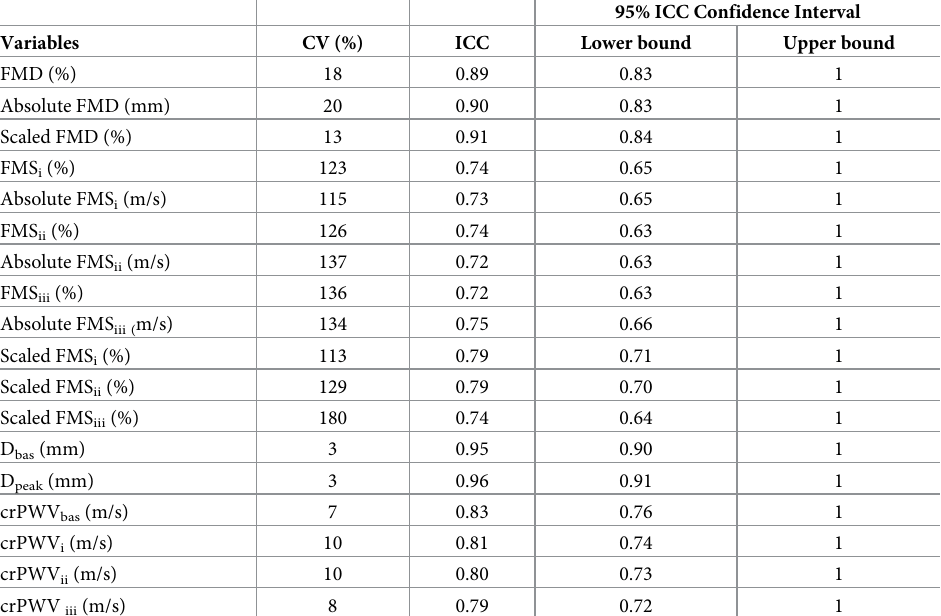
Table 2. Intra-day repeatability statistics.